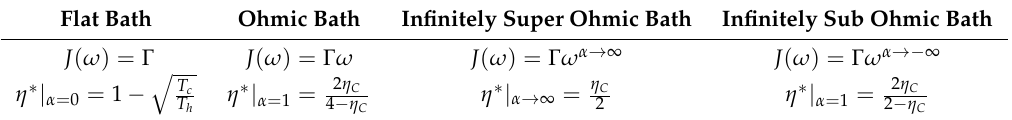
Table 1. Spectral density of the thermal baths and the correspective efficiency at maximum power (EMP) in the low dissipation limit. Notice that in the case of flat and ohmic spectral densities we recover respectively the CA and the SS